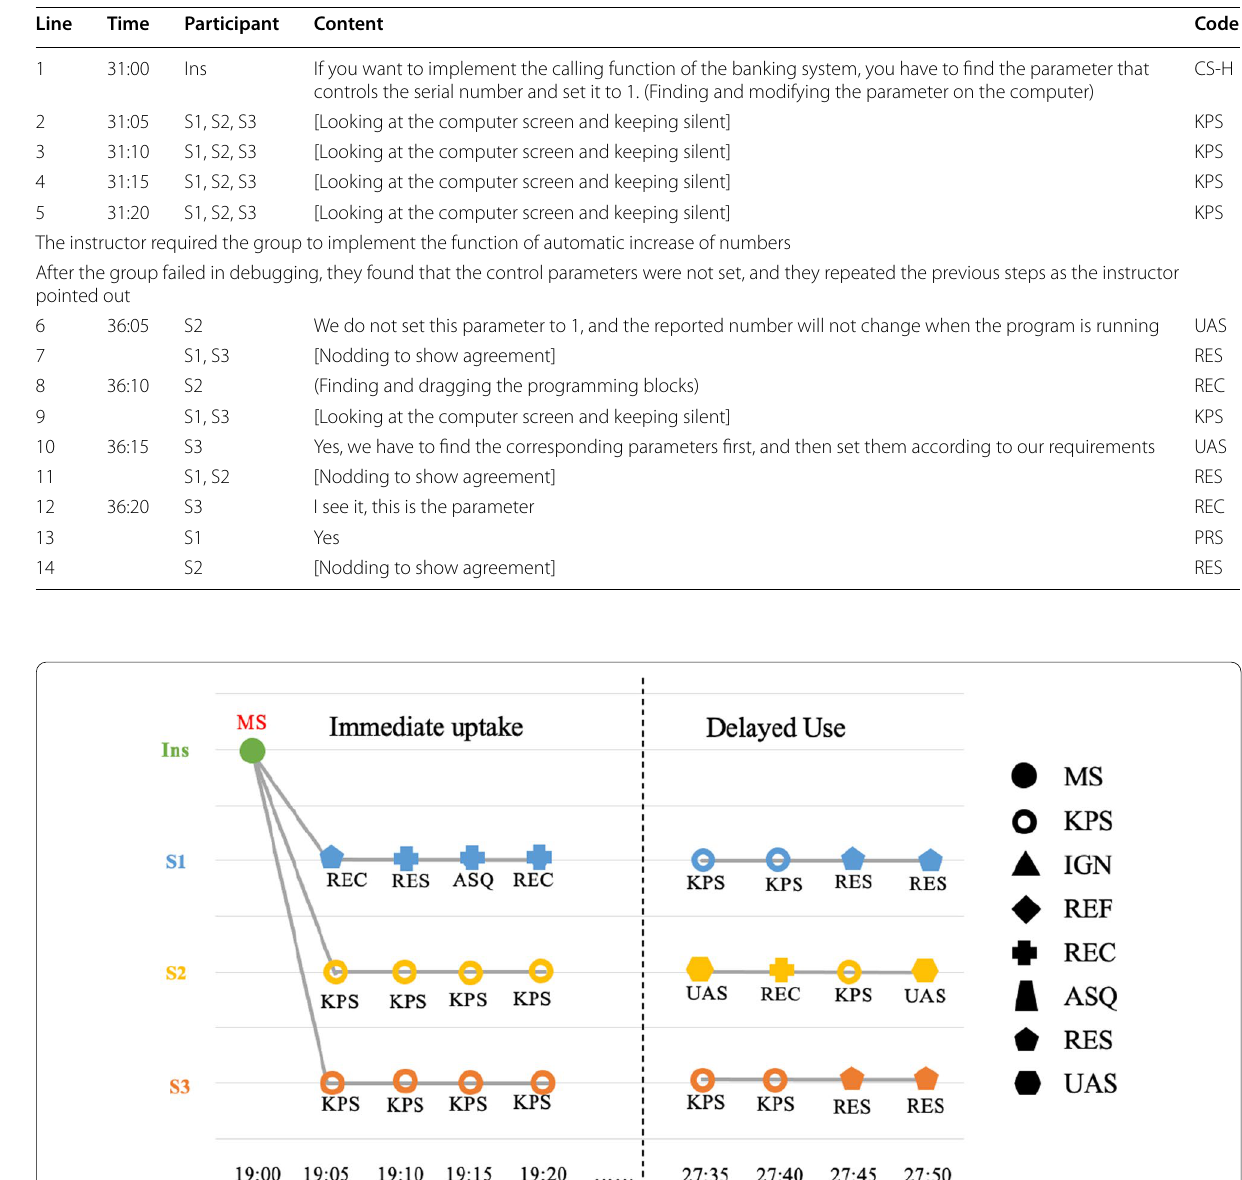
Table 7 The exemplified fragment of Group 6’s delayed use of the CS-H scaffolding